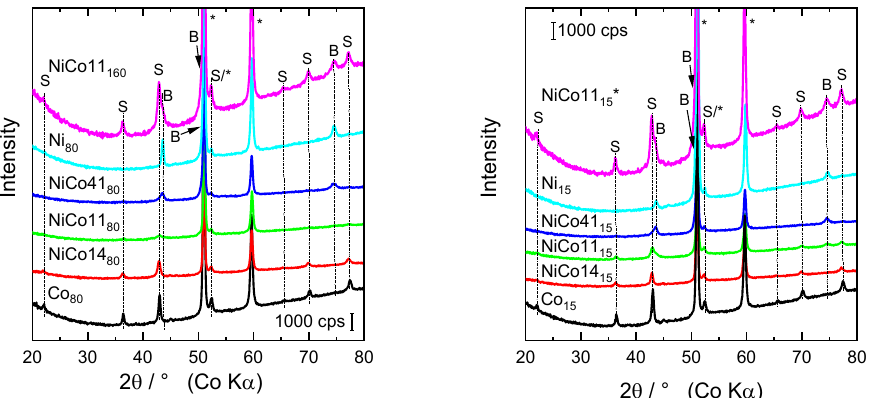
Figure 2. Powder XRD patterns of the sputtered Ni-Co oxide catalysts. B—NiO (bunsenite), S—Ni-Co spinel, *—stainless-steel support.